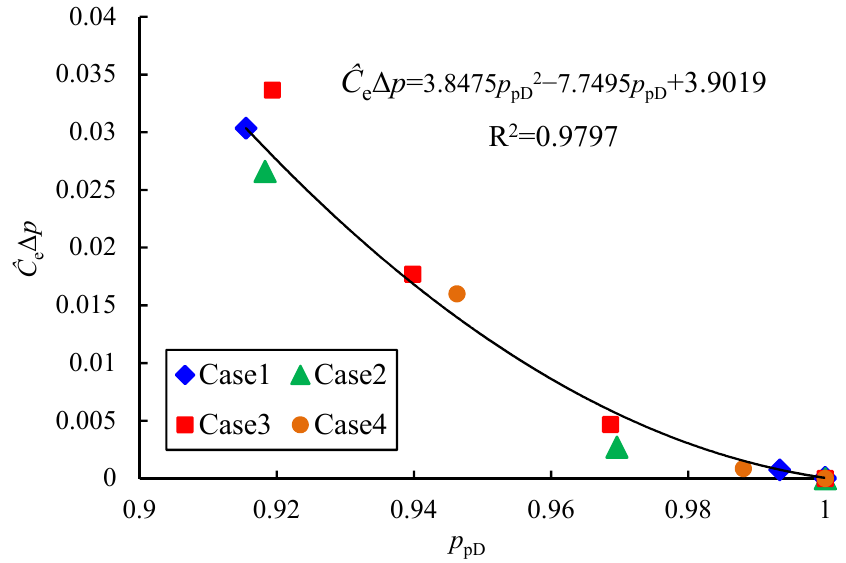
Figure 3. Fitting diagram of the relationship between gas fields ˆ C e ∆ p and p pD . Figure 3. Fi tt ing diagram of the relationship between gas fi elds Ĉ e Δ p and p pD .